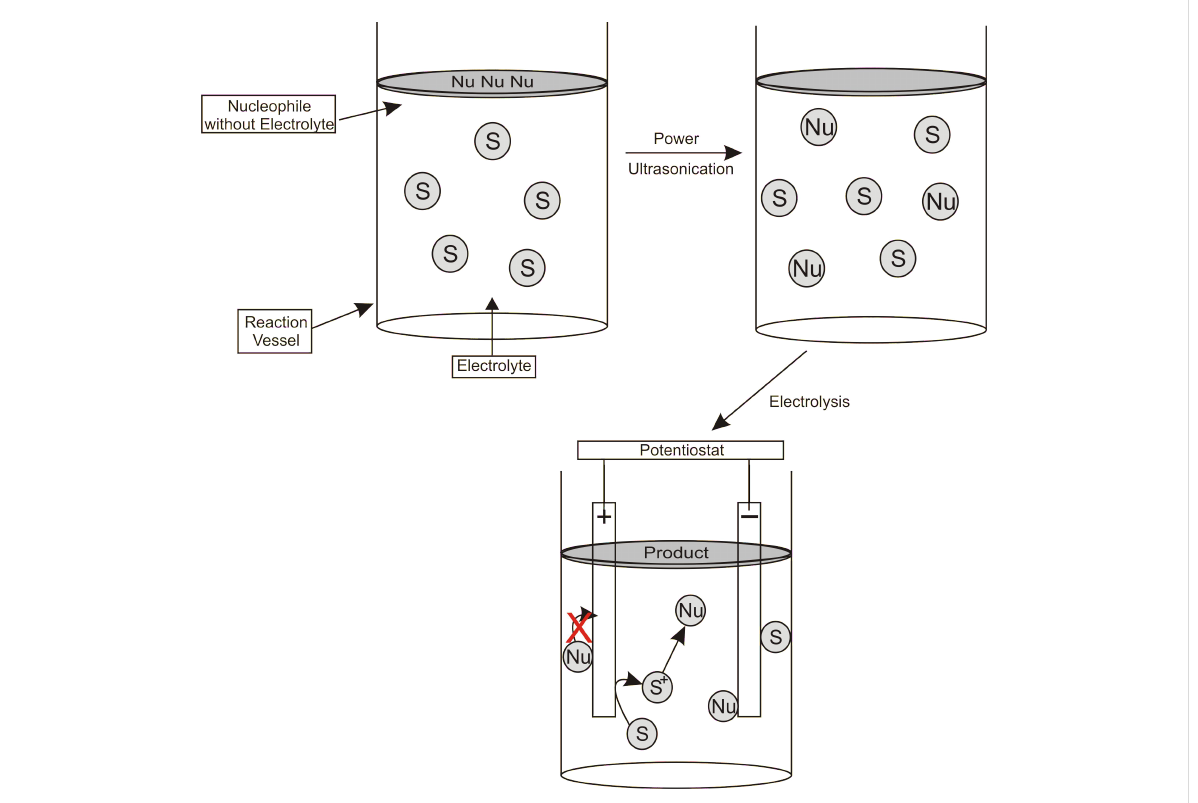
Figure 4: Schematic illustration of the anodic substitution reaction system using acoustic emulsification. Figure redrawn from reference [45].